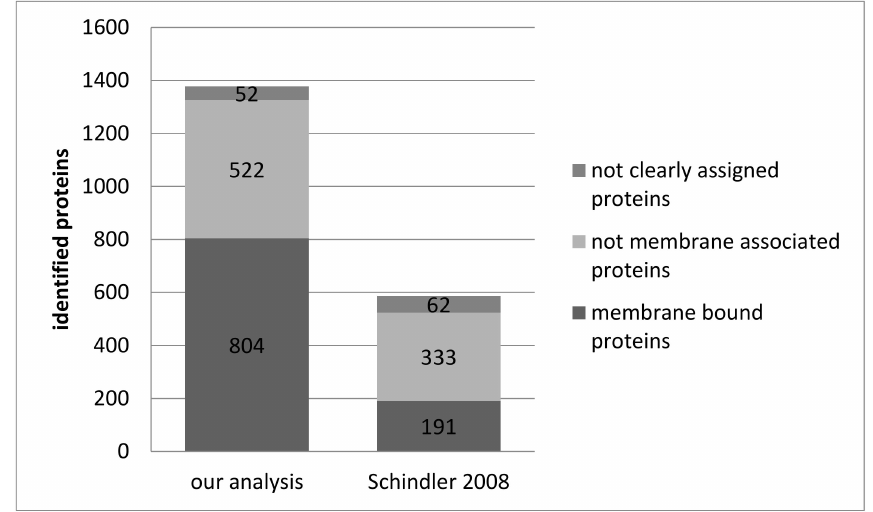
Figure1. Thenumberofproteinidentificationsinplasma-membrane-enrichedsamplesofratcerebellum. Plasma membrane proteins were enriched in samples of adult rat cerebellum. Proteins were identified with LC-MS. Subcellular protein localization was assigned with aid of the database